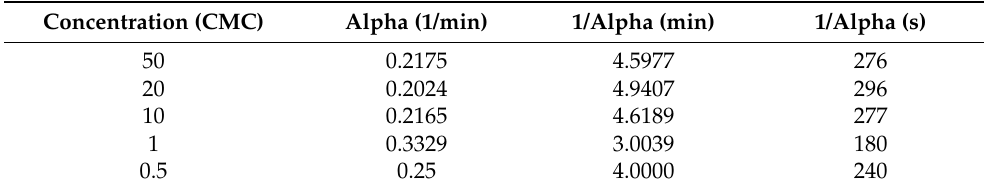
Table 6. The characteristic time scale obtained using Equation (4) for foams produced with SDS solutions with distilled water.